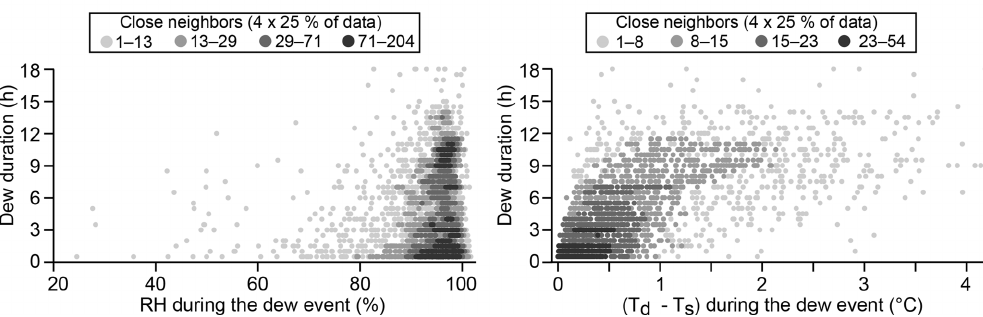
Figure 7. Density plot on a nightly timescale of the dew duration versus relative humidity (a) and dew duration versus T d − T s (b) , both averaged over the dew duration (all sites included). Four shades of grey indicate the number of neighbors around a data point in a small rectangle ( ∼ 2% of the figure). Each shade of grey represents 25% of the total number of nights.